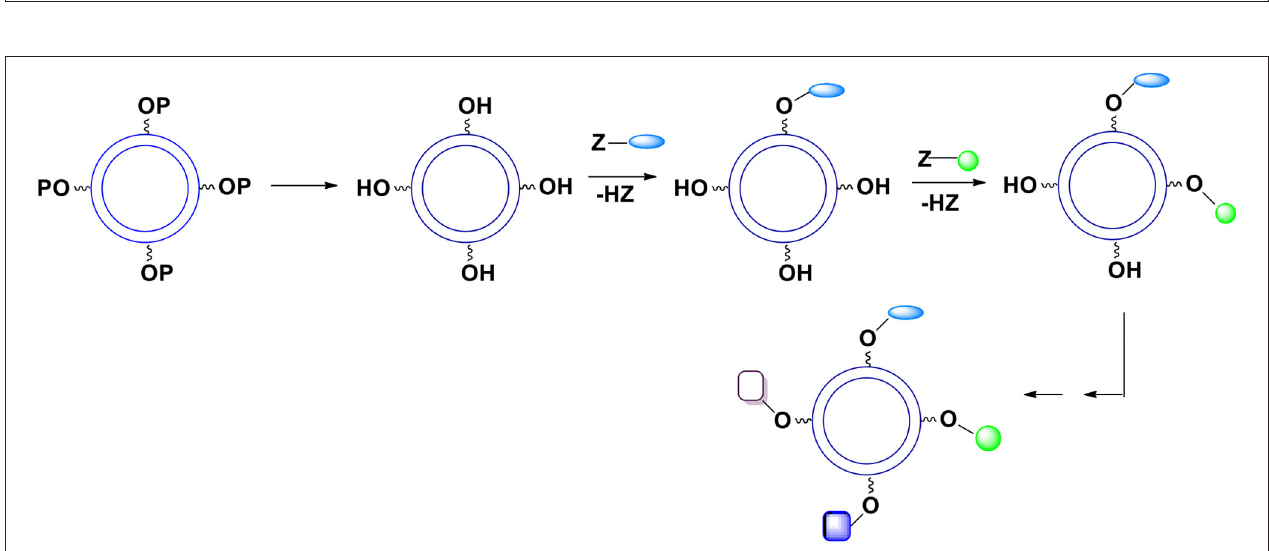
FIGURE 11 | Deprotection of surface hydroxyl groups followed by a gradual introduction of surface moieties. P represents a protecting group. The relative kinetics of introduction of new surface groups is of no